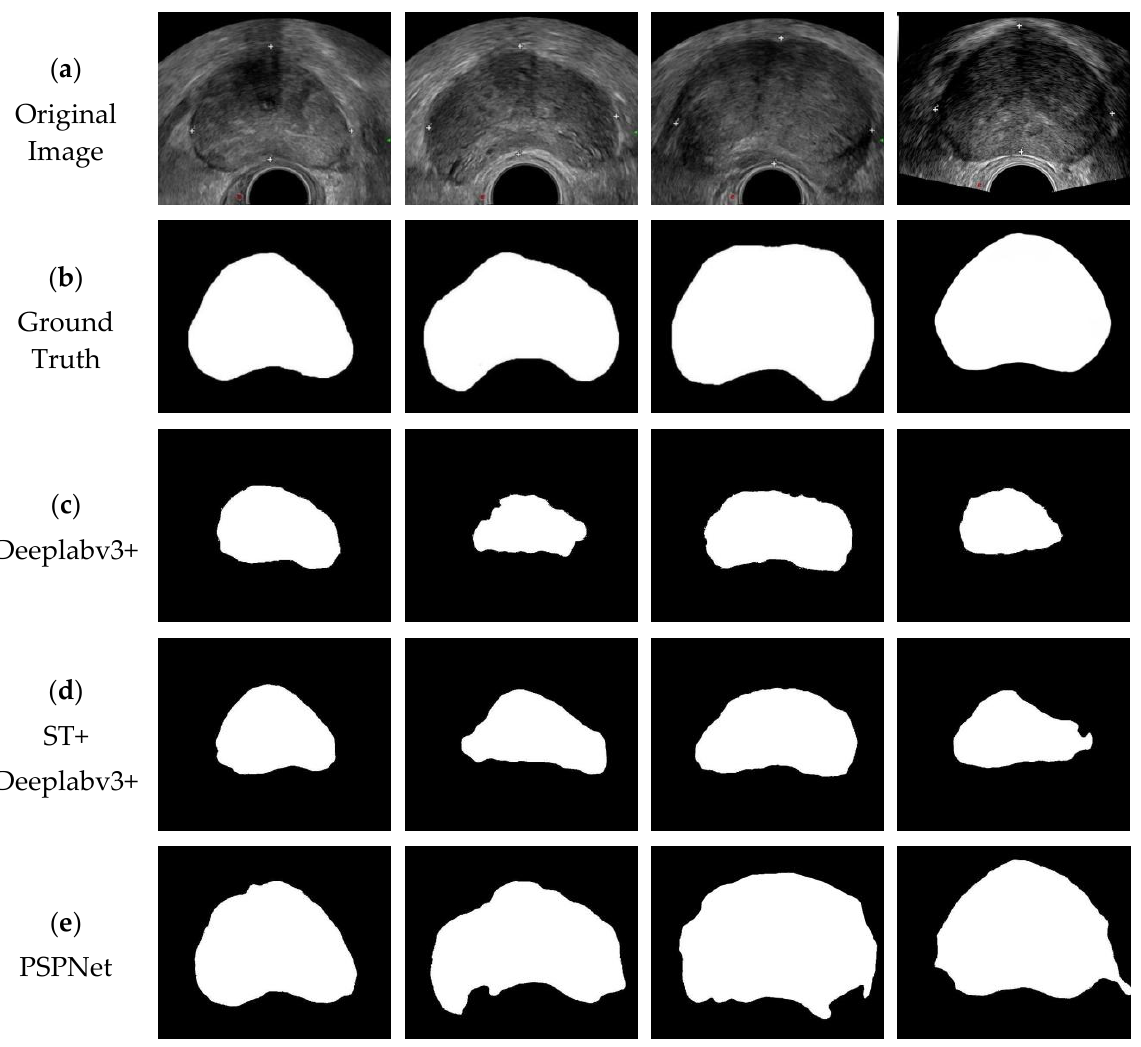
Table 2. Experimental results of prostate segmentation in TRUS images.